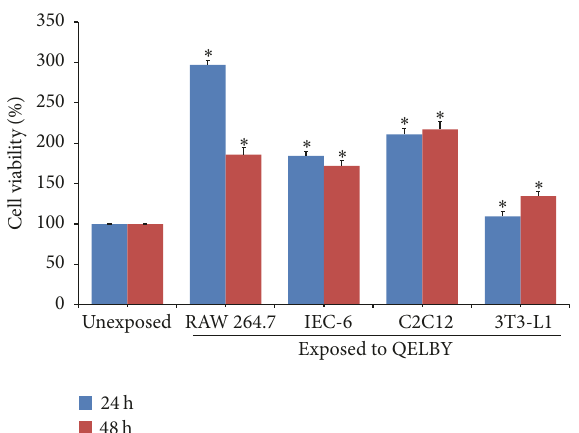
Figure 13: The effects of the media prepared with the deionized water treated in a noncontact manner on the viability of various cells. The deionized water was treated for 48 hours. Blue and red bars indicate the length of incubating time, 24 hours and 48 hours, respectively. Data are mean ± SD (𝑛 = 6) . Bars with ( ∗ ) are significantly different compared to their unexposed counterpart group ( 𝑝 < 0.05 ).